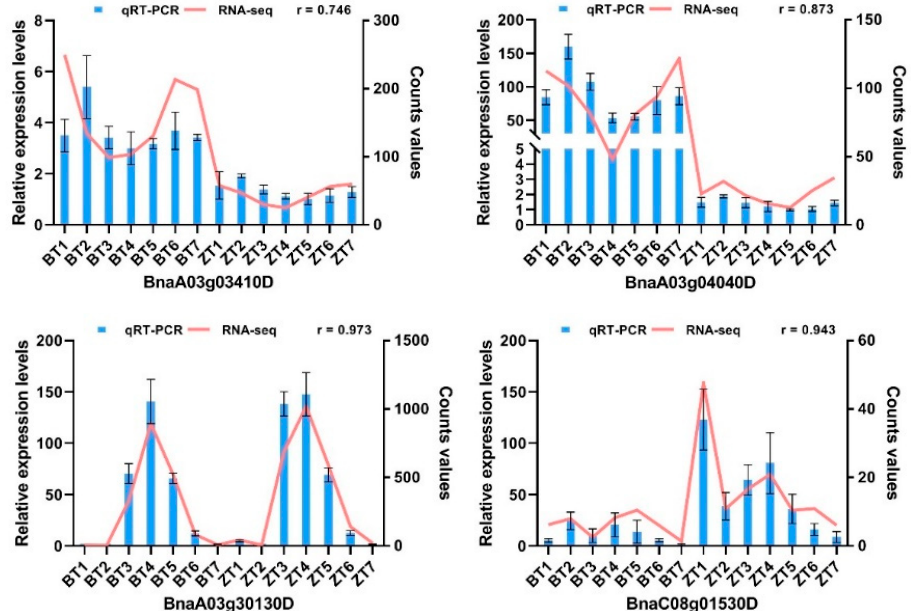
Figure 6. qRT-PCR validation of four candidate gene expression levels. Column charts illustrate relative gene expression levels (mean ± SE) obtained by qRT-PCR. Line charts illustrate gene expres- sion counts values obtained by RNA-seq. r represents the Pearson correlation coefficient of gene expression obtained by qRT-PCR and RNA-seq.